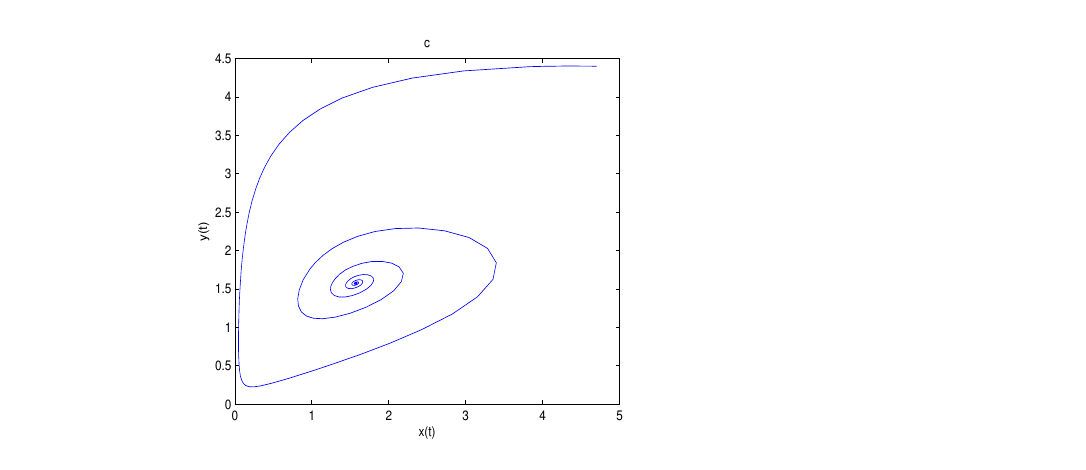
Figure 5. The positive equilibrium point A 1 = ( 1.574,1.574 ) of system (9) is globally asymptotically stable when r = 1.888, ω = 0.9, b = 1, c = 1.213, α = 0.51. Subfigure ( a ) is time series of x ( t ) , subfigure ( b ) is time series of y ( t ) , and subfigure ( c ) is phase diagram of system (9).